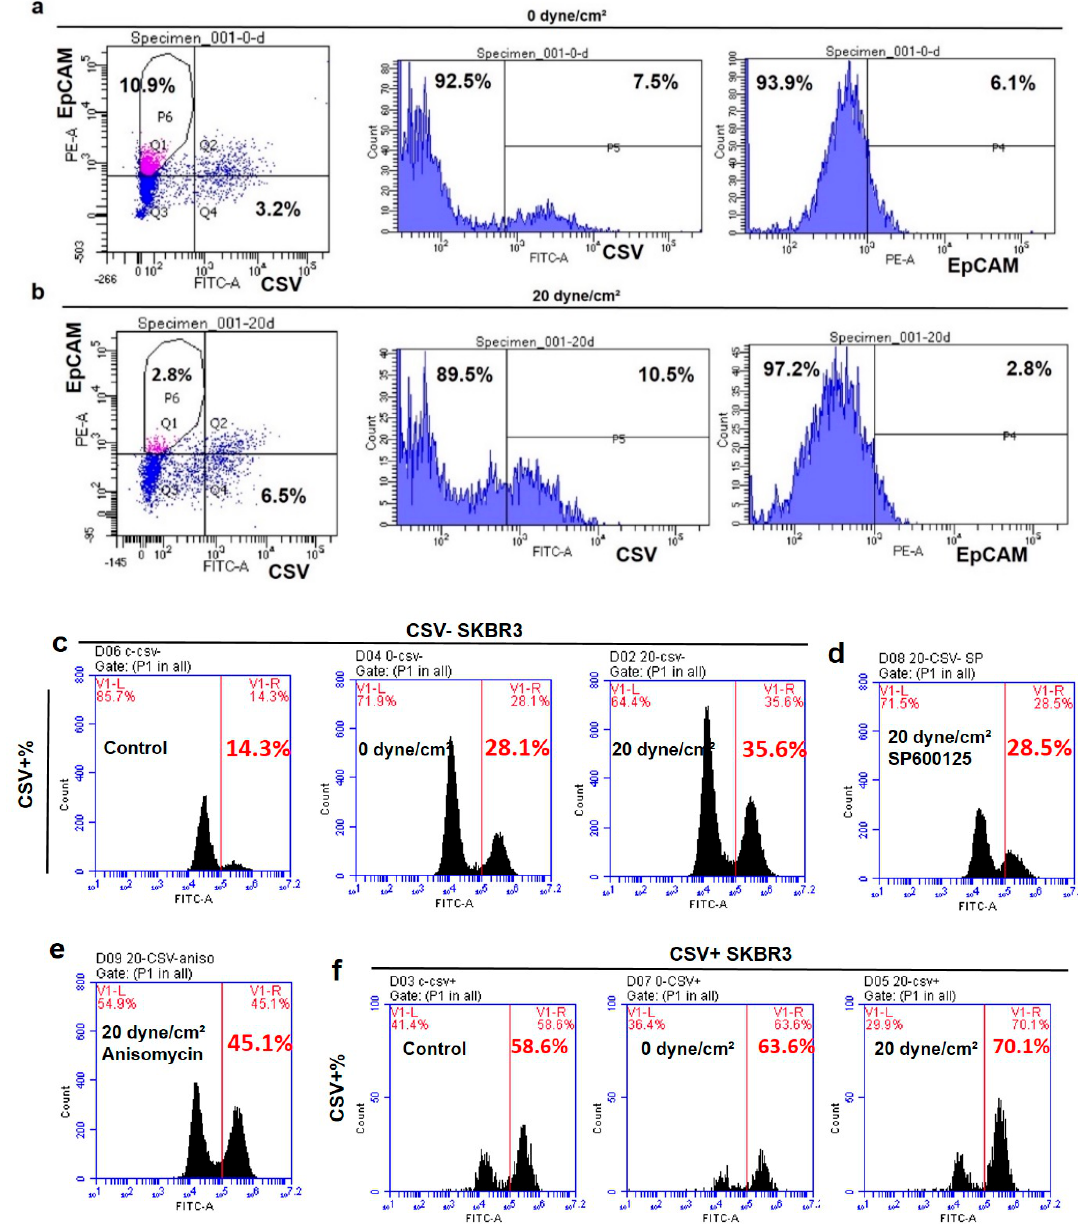
Figure 4. Fluid shear stress facilitates the transition of epithelial circulating tumor cells (CTCs) into mesenchymal status. ( a – c ) The transition of epithelial tumor cells into mesenchymal phenotype under fluid shear stress. EpCAM+/CSV − and CSV − cells were sorted out from untreated SKBR3 cells and then exposed to 0 and 20 dyne/cm 2 shear stress for 12 h. The percentages of EpCAM+/CSV − , CSV+, and EpCAM+ subpopulations were measured by flow cytometry. ( d , e ) The role of JNK signaling in the transition of epithelial CTCs into mesenchymal status. The sorted CSV − cells were exposed to 20 dyne/cm 2 shear stress in the presence of SP600125 or Anisomycin. ( f ) The enrichment of pre-existing mesenchymal tumor cells by shear stress. The sorted CSV+ cells were exposed to 0 and 20 dyne/cm 2 shear stress as well as cultured in petri dishes for 12 h, when the fraction of CSV+ cells was analyzed. All the flow cytometry figures were representative of two independent experiments.